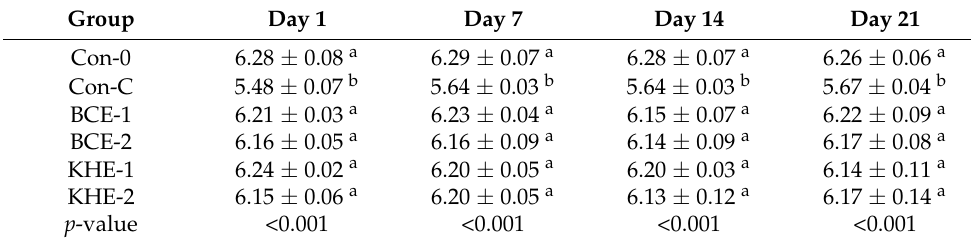
Table 3. Change in pH of analyzed products over time of